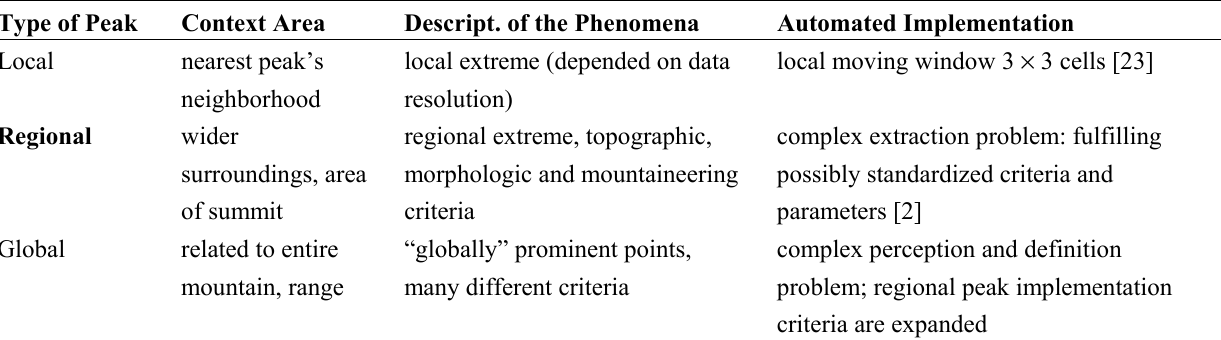
Table 1. The characteristics and detection potential of local, regional and global